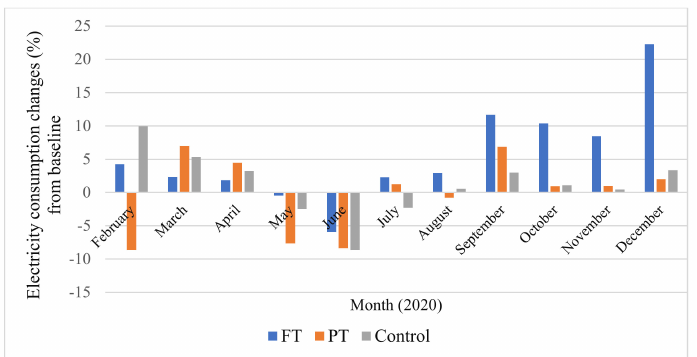
Figure 2. Household electricity consumption (kWh) changes from baseline for the Full Treatment, Partial Treatment and Control between February 2020 and December 2020.